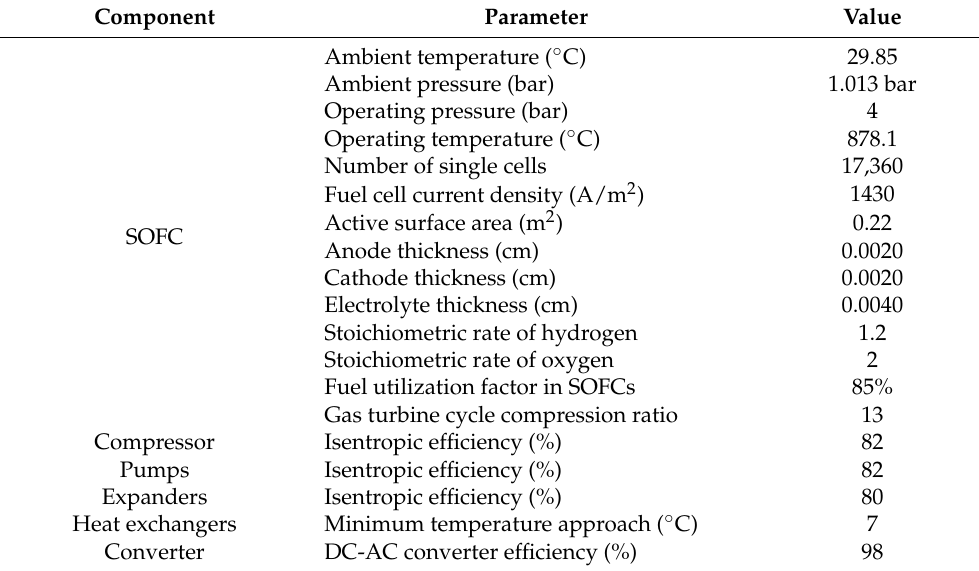
Table 5. The design and operating parameters of system.